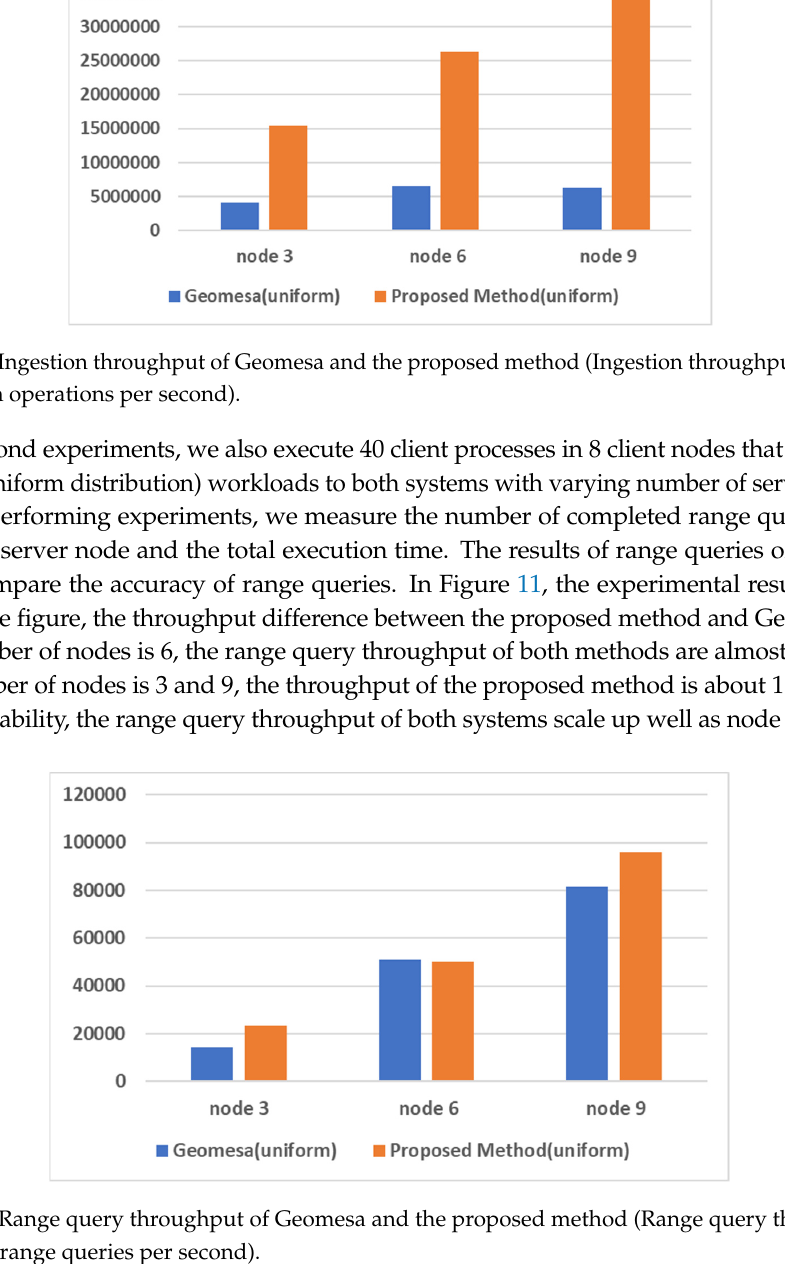
Figure 9. GPS coordinate area used for data generation.